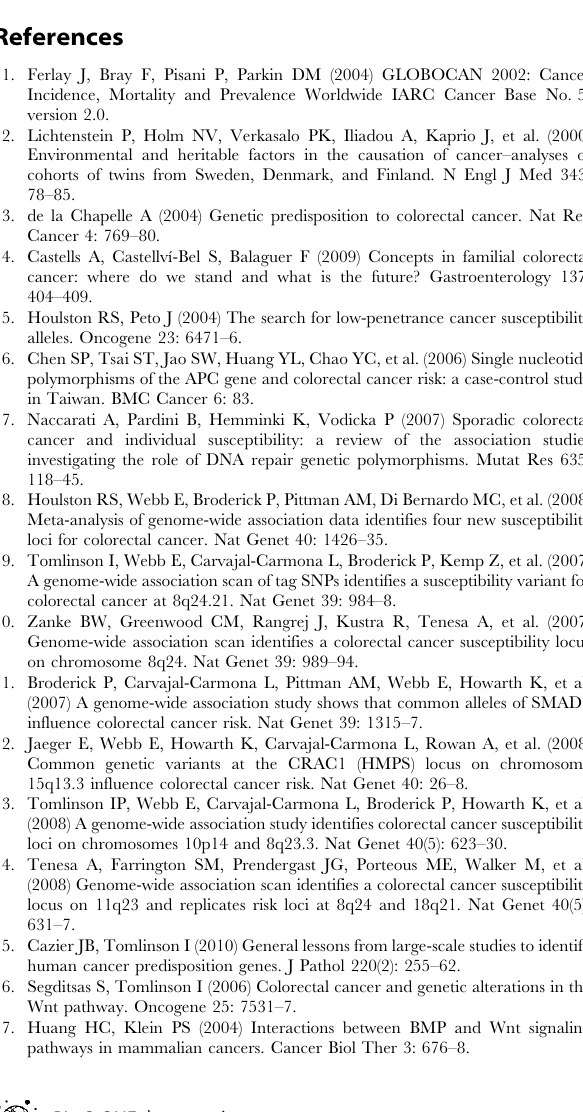
Figure 1. Linkage disequilibrium blocks for the BMP4 and CDH1 genes. R-squared relationships between SNP pairs: A. rs4444235-rs17563 in BMP4 and B. rs9929218-rs1801552 in CDH1